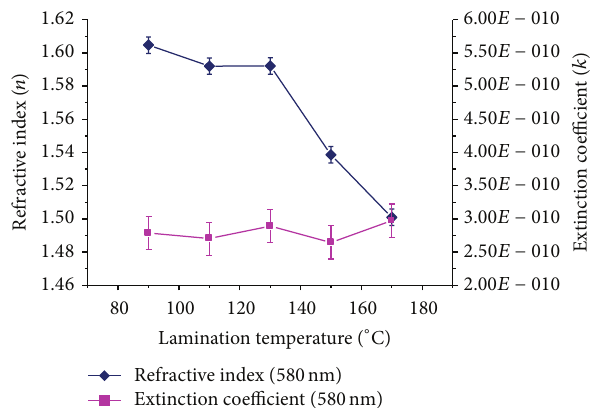
Figure 7: The optical constants of EVA made at various lamination temperatures, a consistent lamination time of 7 minutes, and wavelength of 580